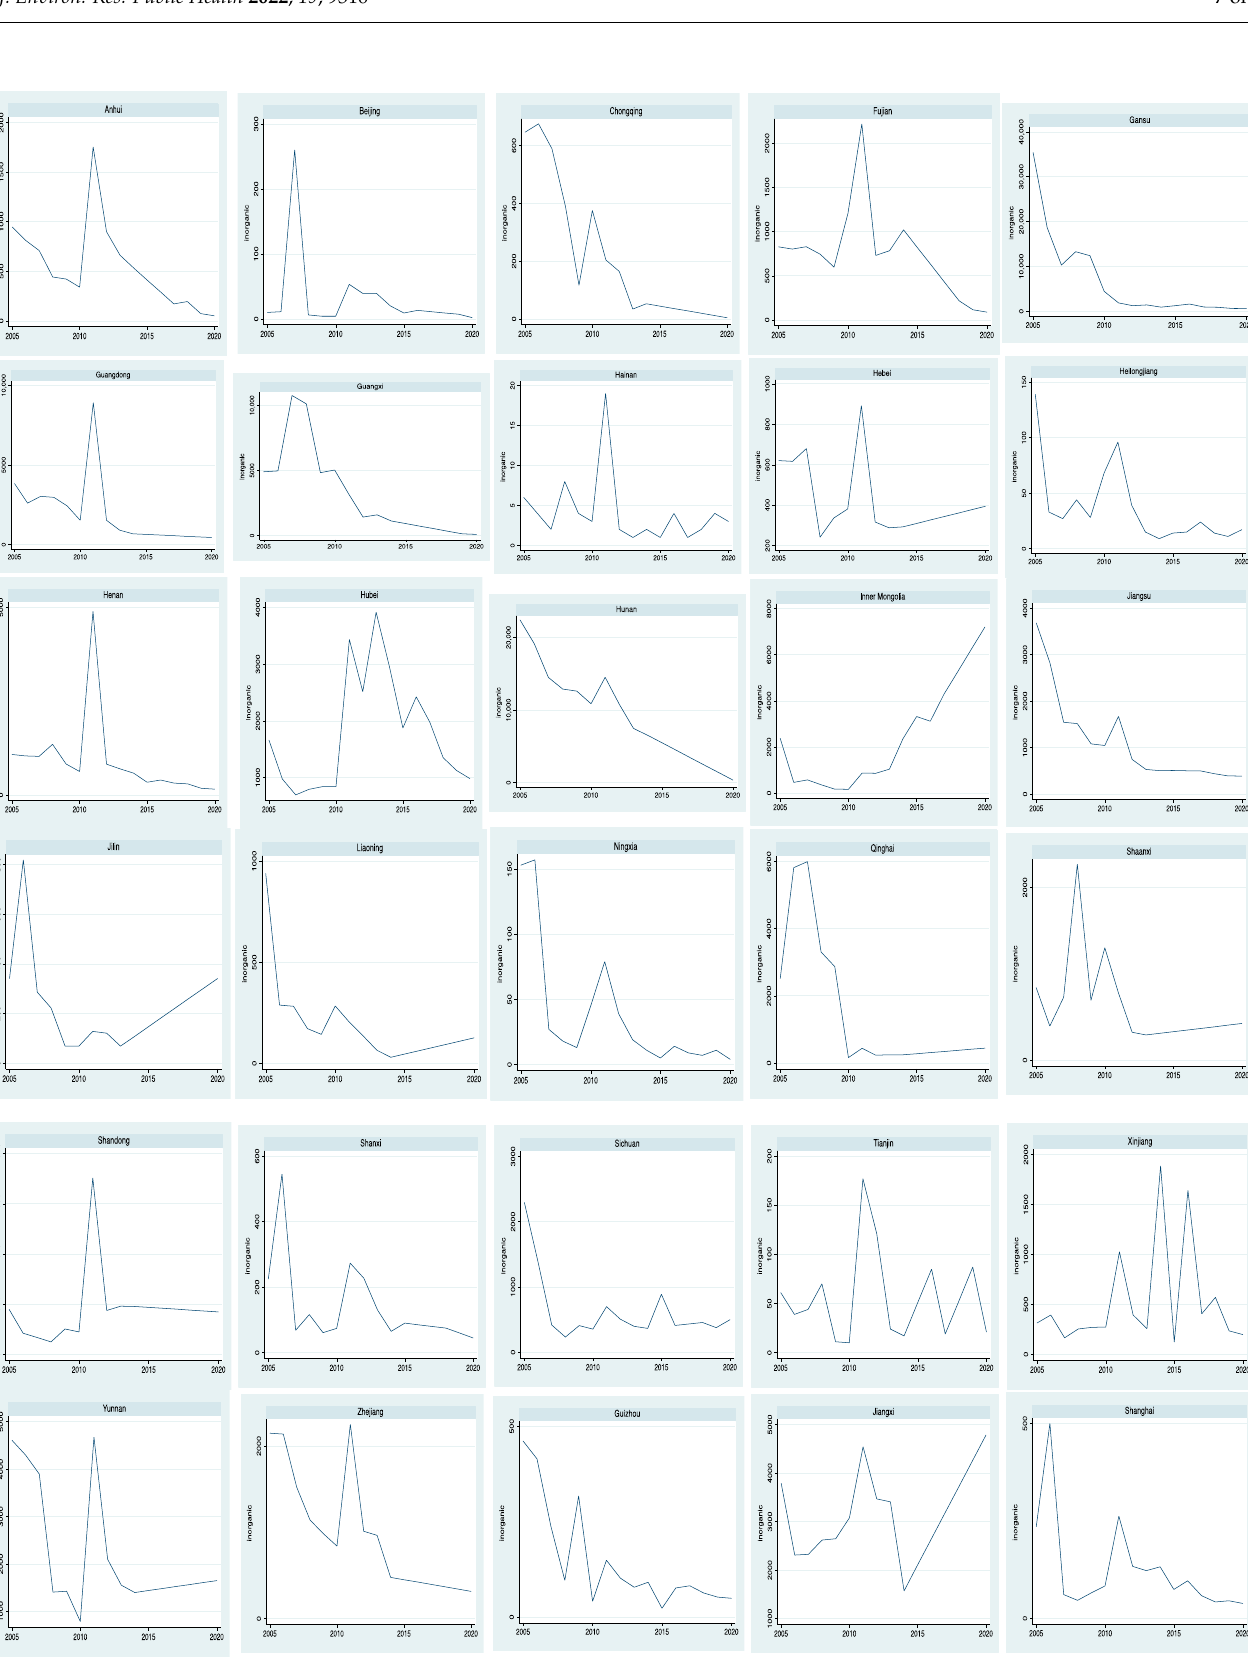
Figure 1. The emissions of inorganic pollutants.